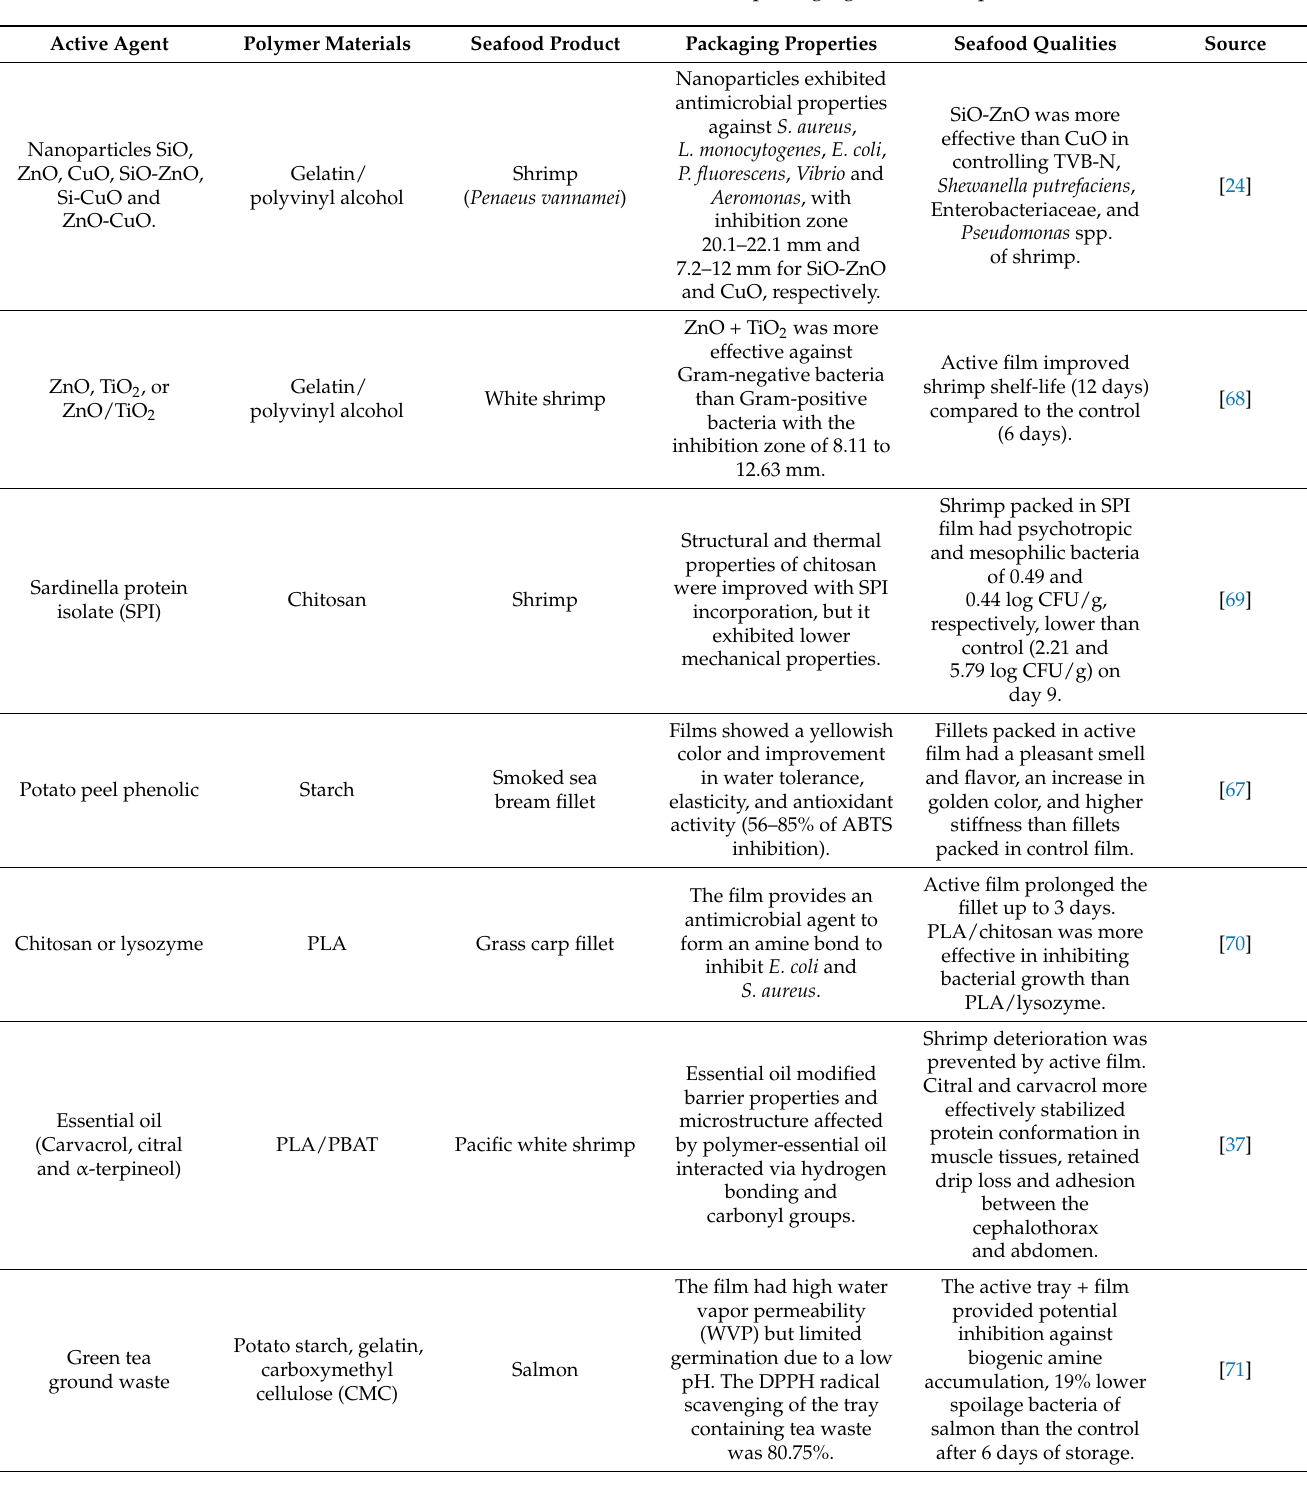
Table 1. Previous recent research on active packaging for seafood